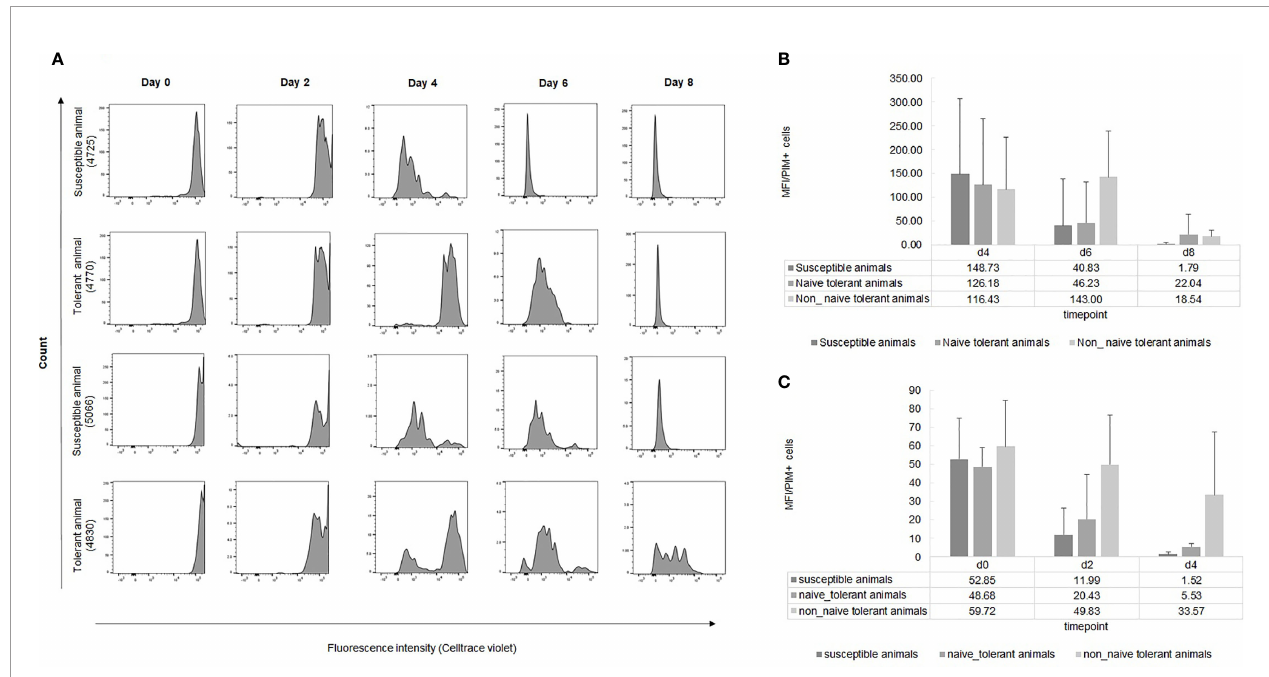
FIGURE 5 | Dye dilution analysis of infected live cells from tolerant and susceptible animals. (A) : Representative examples of the division of live infected cells from seven tolerant and nine susceptible animals measured by CTV dye dilution during the fi rst week of culture after infection in vitro . (B , C) : Results are presented as MFI of CTV of PIM+ cells at different time points during the fi rst (B) and the second (C) week of infection. The bars represent